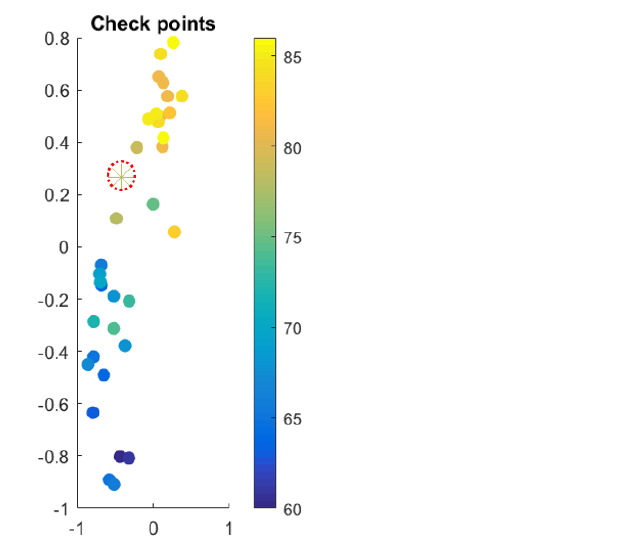
Figure 7. Interpolation space z with color scaling with the values of the effective thermal conductivity K 22